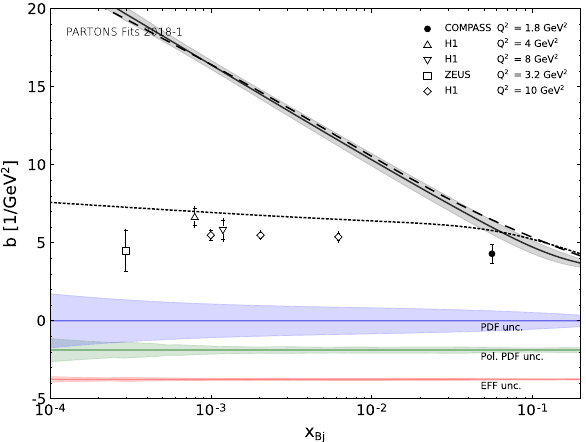
Fig. 9 Comparison between the results of this analysis, selected GPD models and experimental data published by COMPASS in Ref. [57] for the slope b at Q 2 = 1 . 8 GeV 2 . Except COMPASS data also those obtained in ZEUS [59] and H1 [58,60] experiments are shown. Note that the shown data differ by Q 2 values indicated in the legend. For further description see Fig.